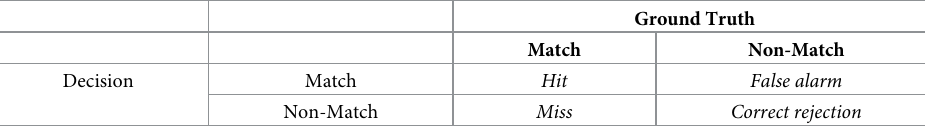
Table 1. Signal detection framework of the correct decisions and errors that can be made in forensic feature com- parison